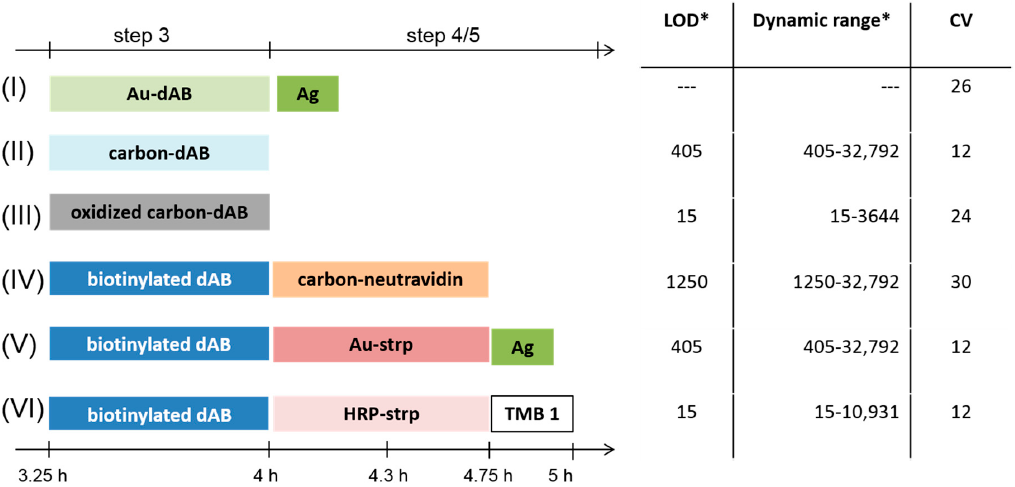
Figure 4. Schematic presentation of the detection of IL8 binding (Incubation Steps 3, 4, and 5) for tested Assay Formats (I)–(VI) including the limit of detection (LOD) (ng/L), dynamic range (ng/L), and coefficient of variation (%). * visually determined.